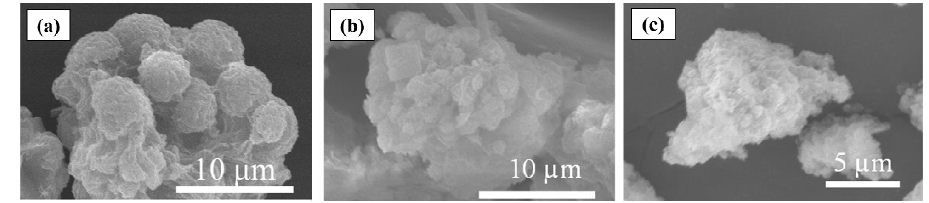
Figure 4. SEM images of products from ( a ) raw ash, ( b ) ash leached once, and ( c ) ash leached four times.